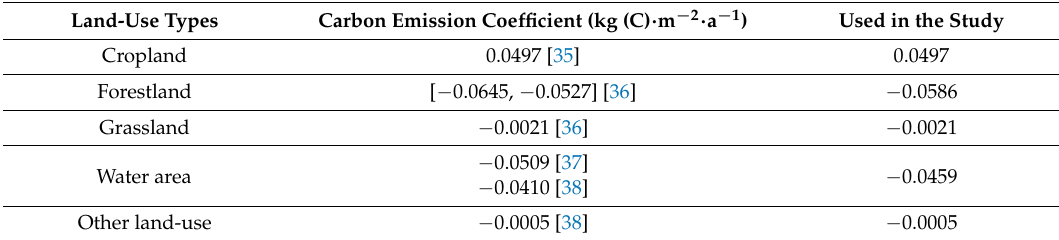
Table 2. Carbon emission coefficients for the five land-use types classified from Landsat image